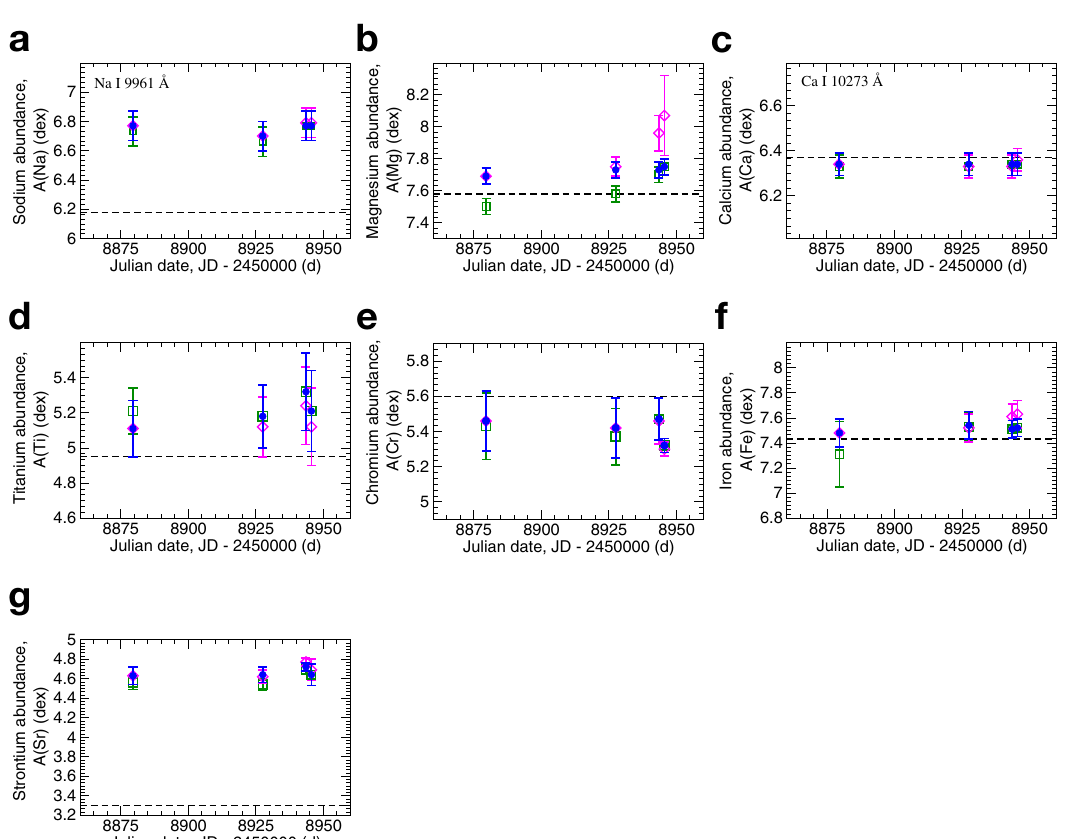
Fig. 4 Chemical composition in the atmosphere of Betelgeuse at four different epochs: 31-01-2020, 19-03-2020, 04-04-2020, and 06-04-2020. a Na abundances calculated under three scenarios. b Mg abundances calculated under three scenarios. c Ca abundances calculated under three scenarios. d Ti abundances were calculated under three scenarios. e Cr abundances were calculated under three scenarios. f Fe abundances were calculated under three scenarios. g Sr abundances calculated under three scenarios. Everywhere, the meanings of symbols are the same as in Fig. 3. The dashed lines show solar abundances obtained in this study. Error bars represent standard deviation. Source data are provided as a Source Data fi